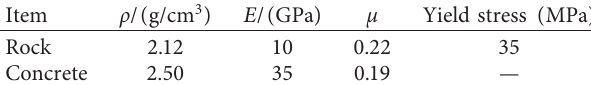
Table 2: Parameters of related rock and concrete.